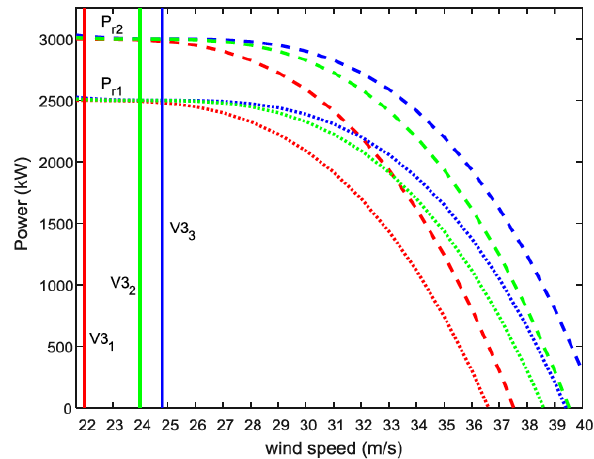
Figure 4. Expanded wind power derating region for P r 1 and P r 2